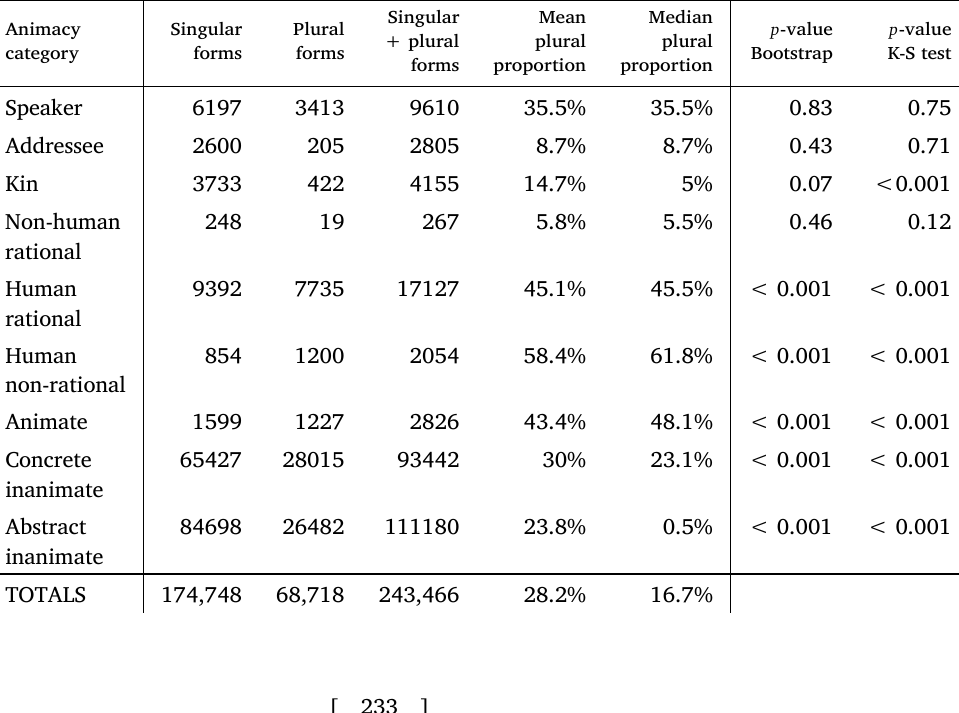
Table 2: Details of the sample of Russian nouns Animacy